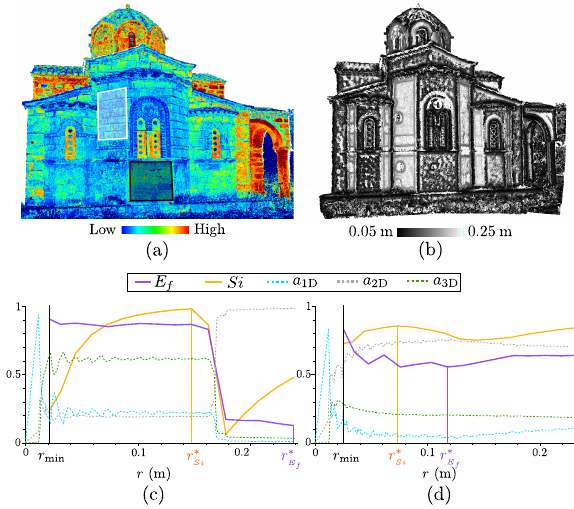
Figure 4: Optimal neighborhood radius retrieval ( TLS dataset). 3D point cloud colored with (a) the intensity and (b) r ∗ . (c-d) Variation of the shape features and radius-selection criteria over the neighborhood radius over 50 points within the white (c) and black (d) rectangles of